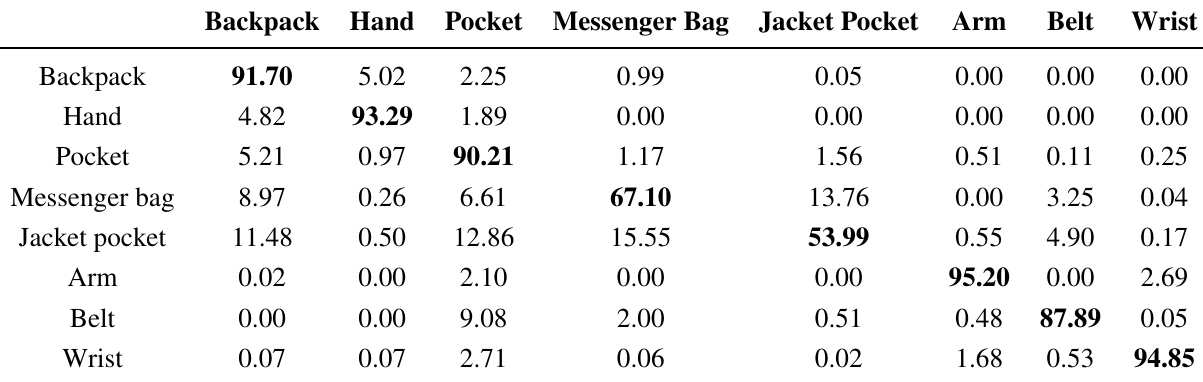
Table 15. Confusion matrices with the mobile activities, random forest, in %. Backpack Hand Pocket Messenger Bag Jacket Pocket Arm Belt Wrist